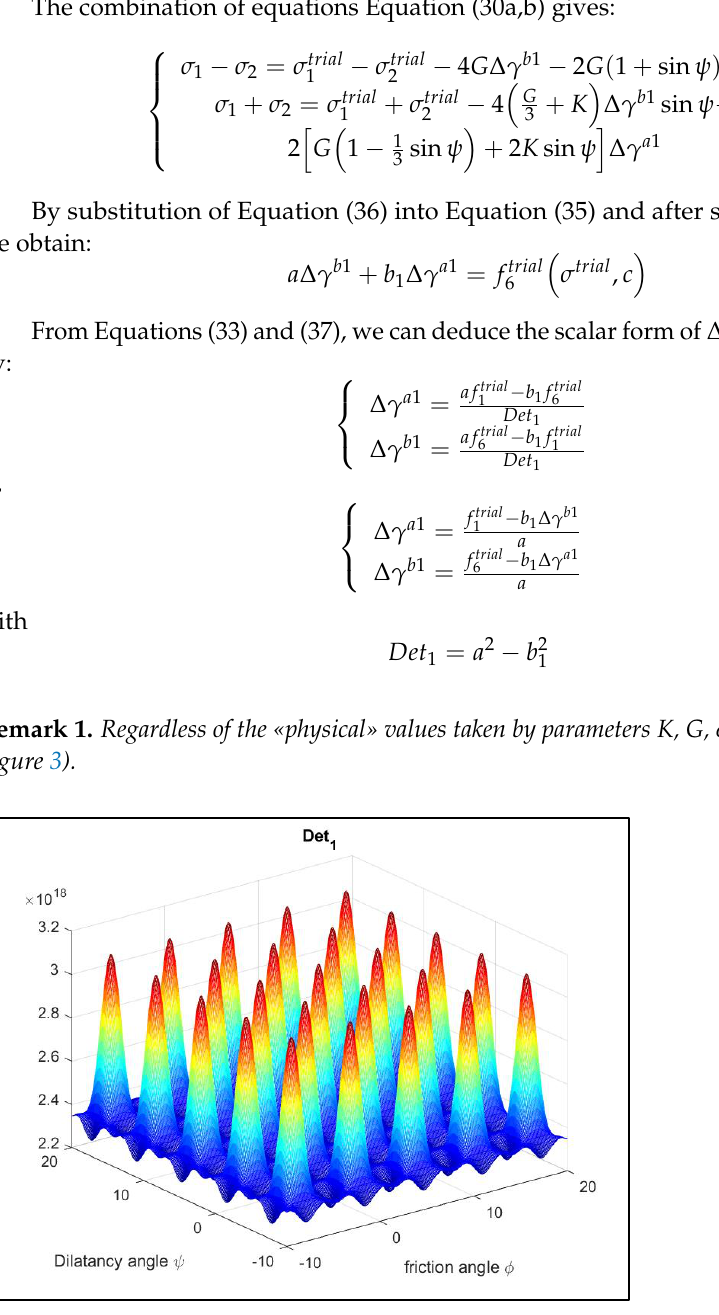
Figure 3. Example of 𝐷𝑒𝑡 1 values for K = 1.67 × 10 8 and G = 6.39 × 10 5 . The fixed-point algorithm applied to the return mapping of the right edge mechanism (Algorithm 4) is based on the constitutive law given in Equation (30). Its initial conditions are also taken in the elastic domain ( 𝜎 1𝑡𝑟𝑖𝑎𝑙 , 𝜎 2𝑡𝑟𝑖𝑎𝑙 , 𝜎 3𝑡𝑟𝑖𝑎𝑙 , 0,0, 𝜀̅ 𝑛𝑝 = 0 ). Algorithm 4 : Fixed point method applied to the right edge mechanism.